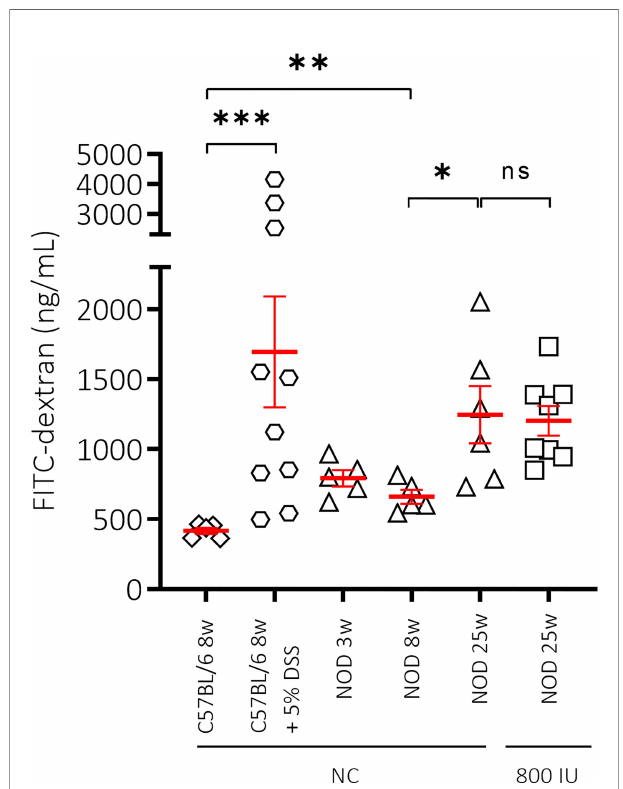
FIGURE 4 | Effect of mouse strain, age and vitamin D substitution regimen on intestinal permeability. Concentration of FITC-dextran as measurement for intestinal permeability is shown for female C57BL/6 mice at 8 weeks of age in addition to female NOD mice at increasing ages (3, 8, and 25 weeks of age). Mice received either normal chow (NC) or the 800 IU/day vitamin D- supplemented diet from 3 until 25 weeks of age. To validate our technique, dextran sulfate sodium (DSS) was added at 5% in drinking water ad libitum for 8 days to 8-week-old C57BL/6 mice. Symbols (N = 3-10) represent individual mice, and the line re fl ects the group mean with SEM. *P ≤ 0.05; **P ≤ 0.01; ***P ≤ 0.001. NS means non signi fi